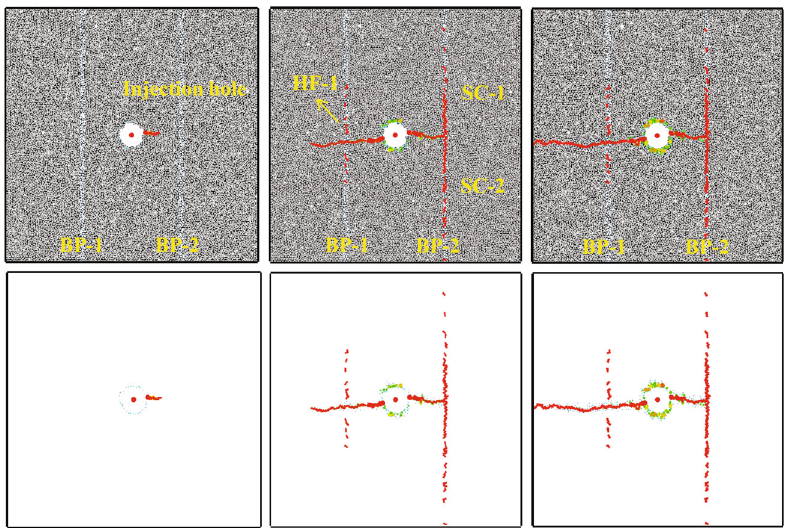
Figure 9: Group 1-2 hydraulic fracture morphology and interactive penetration mode.